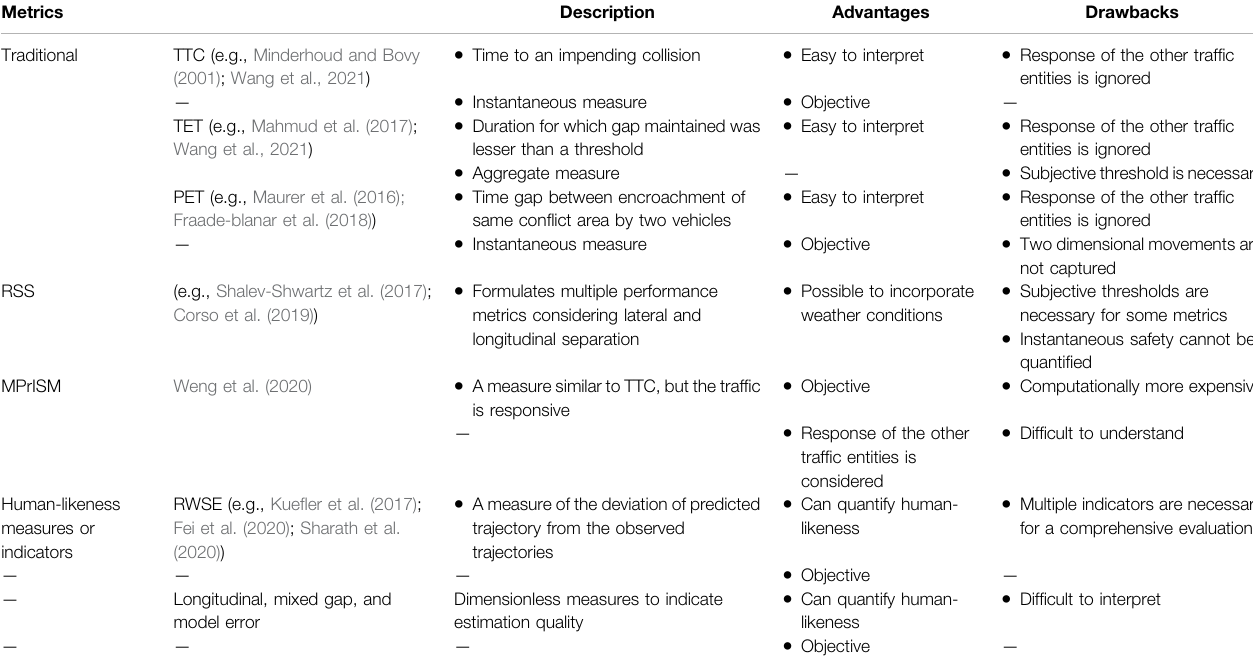
TABLE 3 | Metrics for motion planning. Metrics